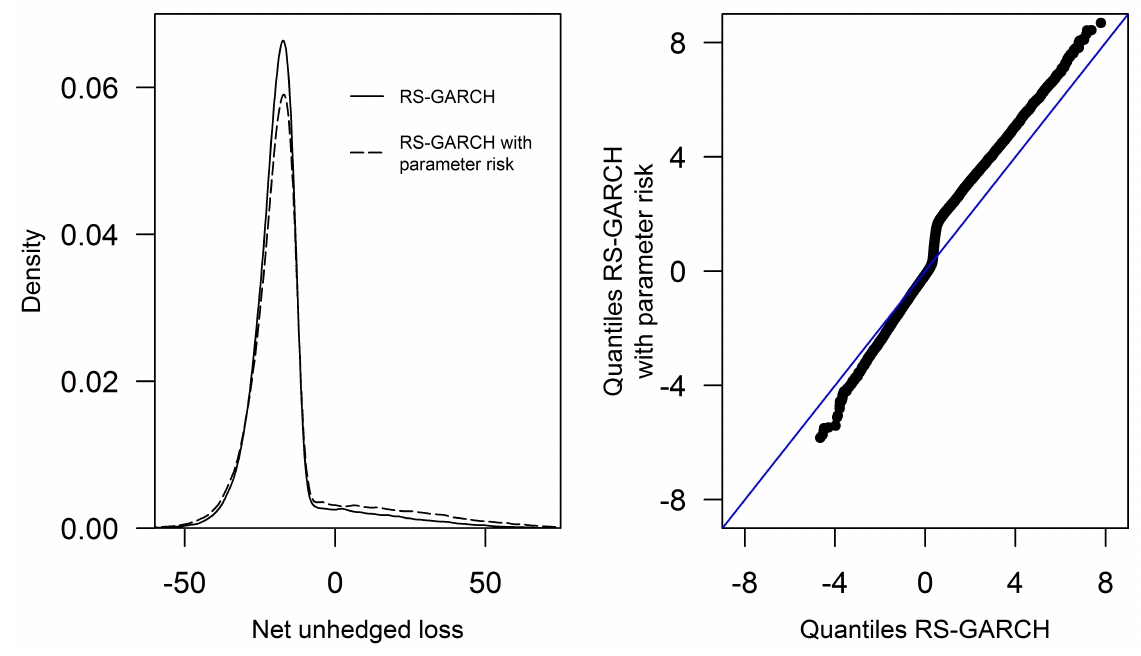
Figure 4. ( Left panel ): Empirical density of the net unhedged loss ( X ) based on 100,000 daily Figure 4 – Left panel: Empirical density of the net unhedged loss ( X ) based on 100,000 daily scenarios projected under the RS-GARCH model with and without parameter risk. ( Right panel ): scenarios projected under the RS-GARCH model with and without parameter risk. Right panel: Q-Q plot of standardized quantiles between these two Q-Q plot of standardized quantiles between these two distributions.